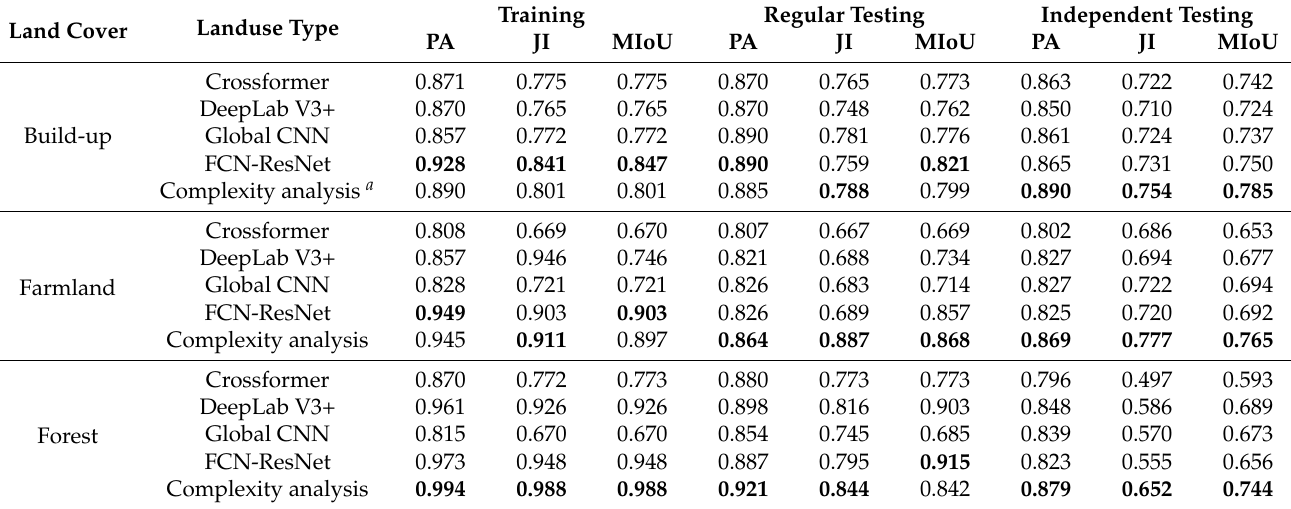
Figure 13. Comparison between waters segmentation results of baseline UNet, UNets with com- plexity-informed constraint/ sampling, and UNet with both. ( a ) shows the RGB images depicting